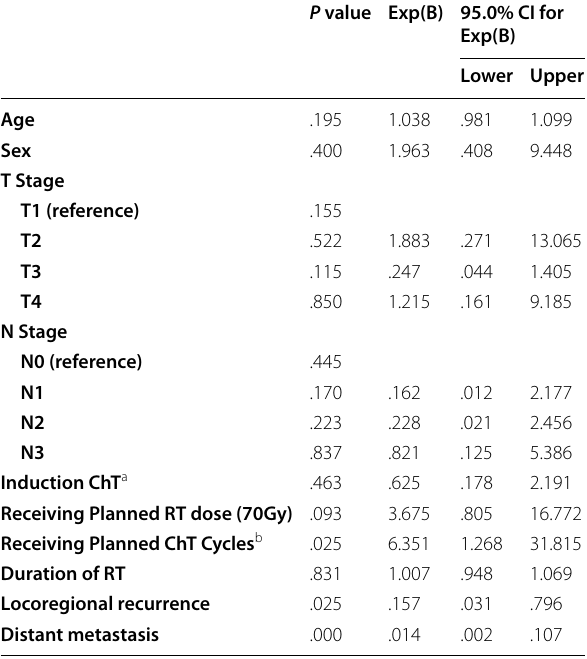
Table 3 Predictors of overall survival (Cox-hazard